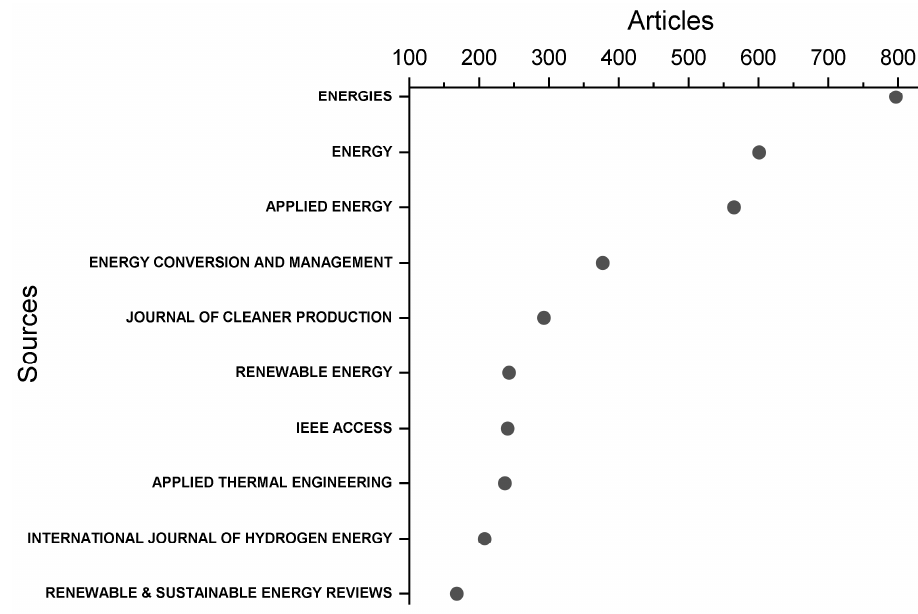
Figure 4. Source documents by year.